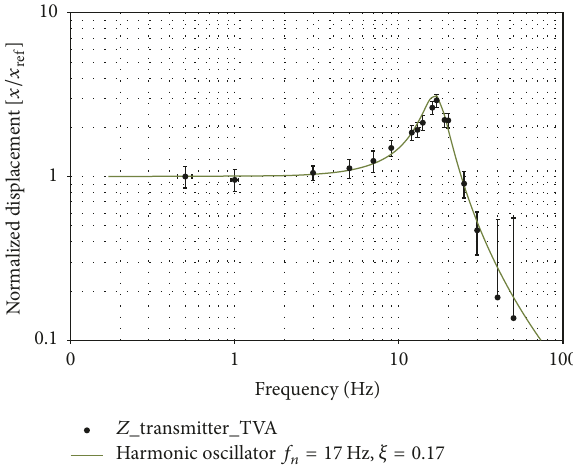
Figure 13: Slow and fast stages stiffness versus slow stage displace- ment during quasistatic (0.1Hz) tests at room temperature.